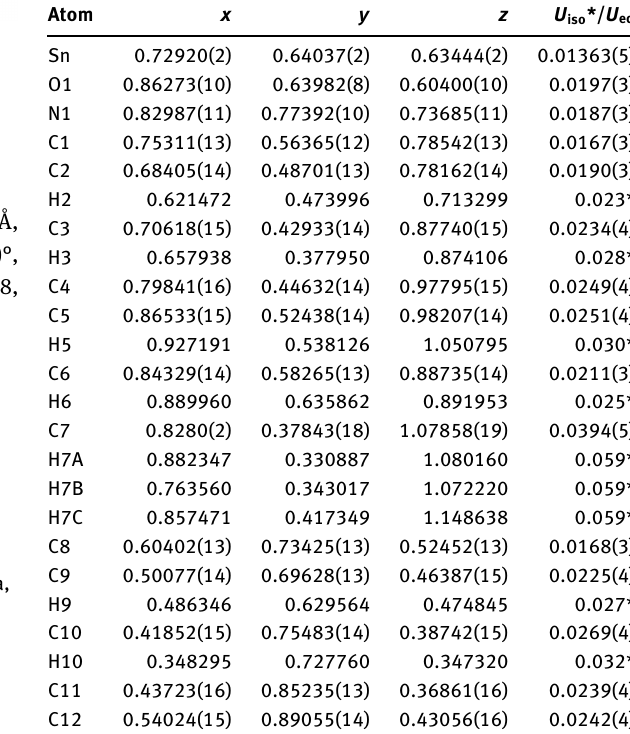
Table 2: Fractional atomic coordinates and isotropic or equivalent isotropic displacement parameters (Å 2